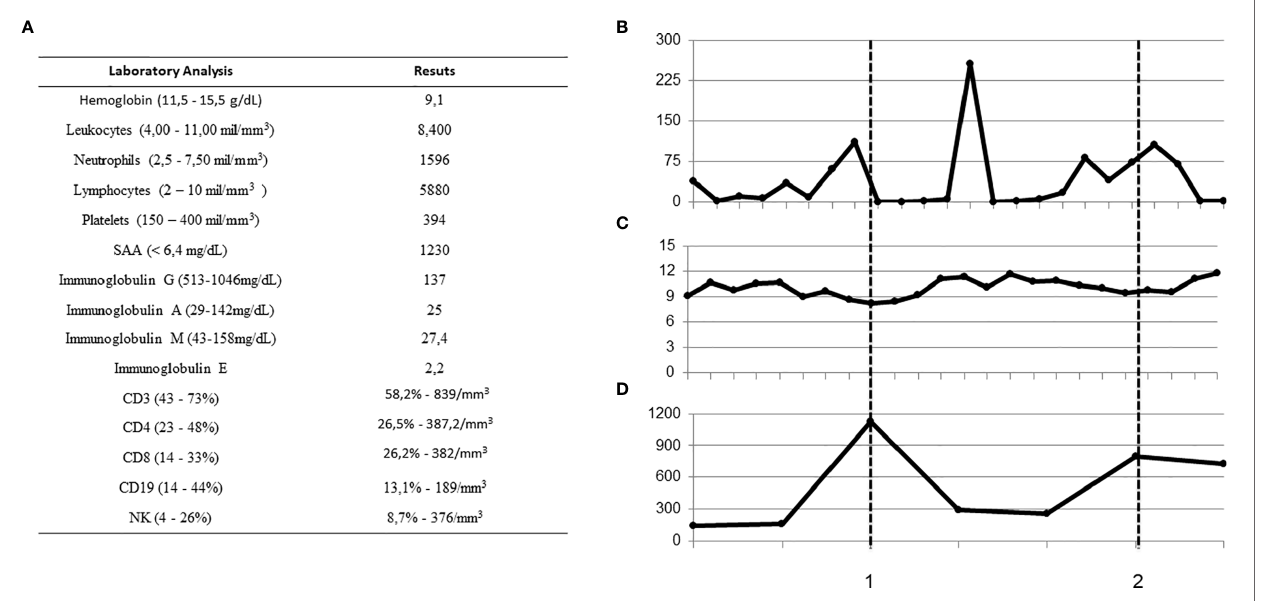
FIGURE 2 | Baseline laboratory fi ndings and treatment response over time. (A) Laboratory fi ndings at baseline (normal ranges in brackets) (B – D) CRP, hemoglobin and Immunoglobulin G over time during febrile episodes and at basal levels. Dashed lines indicate immunoglobulin replacement, 1: single shot, and 2: after monthly infusions. (CRP, C-reactive protein; SAA, serum amyloid